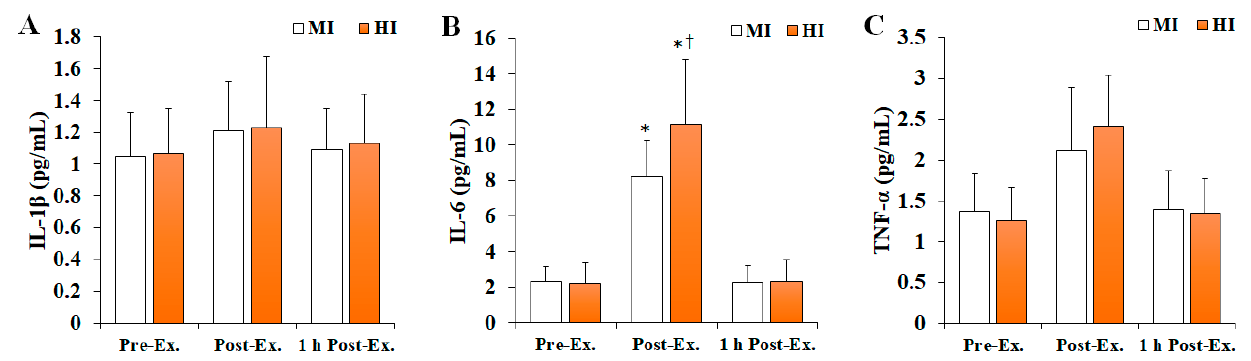
Figure 2. The changes in inflammatory markers after treadmill running at different exercise intensities. Values are presented as mean ± SD. ( A ) IL-1 β : interleukin-1 β , ( B ) IL-6: interleukin-6, ( C ) TNF- α : tumor necrosis factor- α , MI: moderate-intensity, HI: high-intensity, Ex: exercise, *: significant difference with pre-exercise and 1 h post-exercise within group ( p < 0.05), †: significant difference with MI group within time ( p < 0.05).